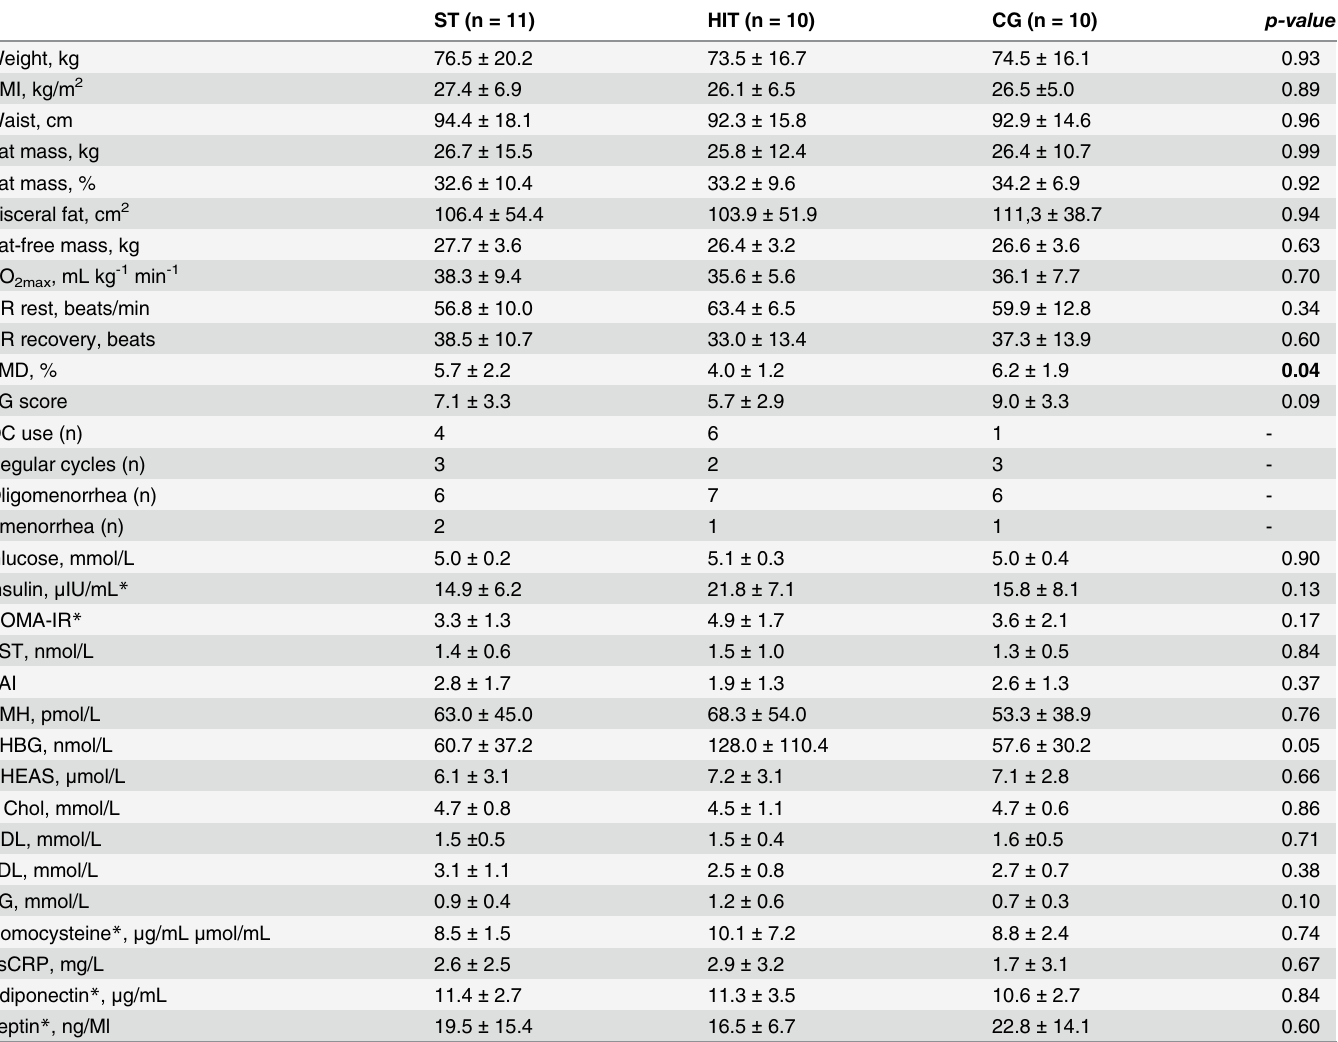
Table 1. Baseline characteristics of randomized participants. Variables are expressed as means ± standard deviation. P-values for between-group com- parisons of continuous variables at baseline (ANOVA). BMI = Body Mass Index, VO 2max = Maximum oxygen uptake, HR rest = resting heart rate, HR recovery = heart rate recovery (maximum heart rate minus heart rate one minute after end of maximum effort exercise test), FMD = flow-mediated dilation, FG score = Ferriman Gallway score, OC use = oral contraceptives use, HOMA-IR = Homeostatic assessment of insulin resistance, TST = Testosterone, FAI = Free Androgen Index (Testosterone x 100/SHBG), AMH = Antimüllarian Hormone, SHBG = Sex-Hormone Binding Globulin, DHEAS = Dehydroepiandrosterone sulfate. T Chol = total cholesterol, HDL = high-density lipoprotein cholesterol, LDL = low-density lipoprotein cholesterol, TG =